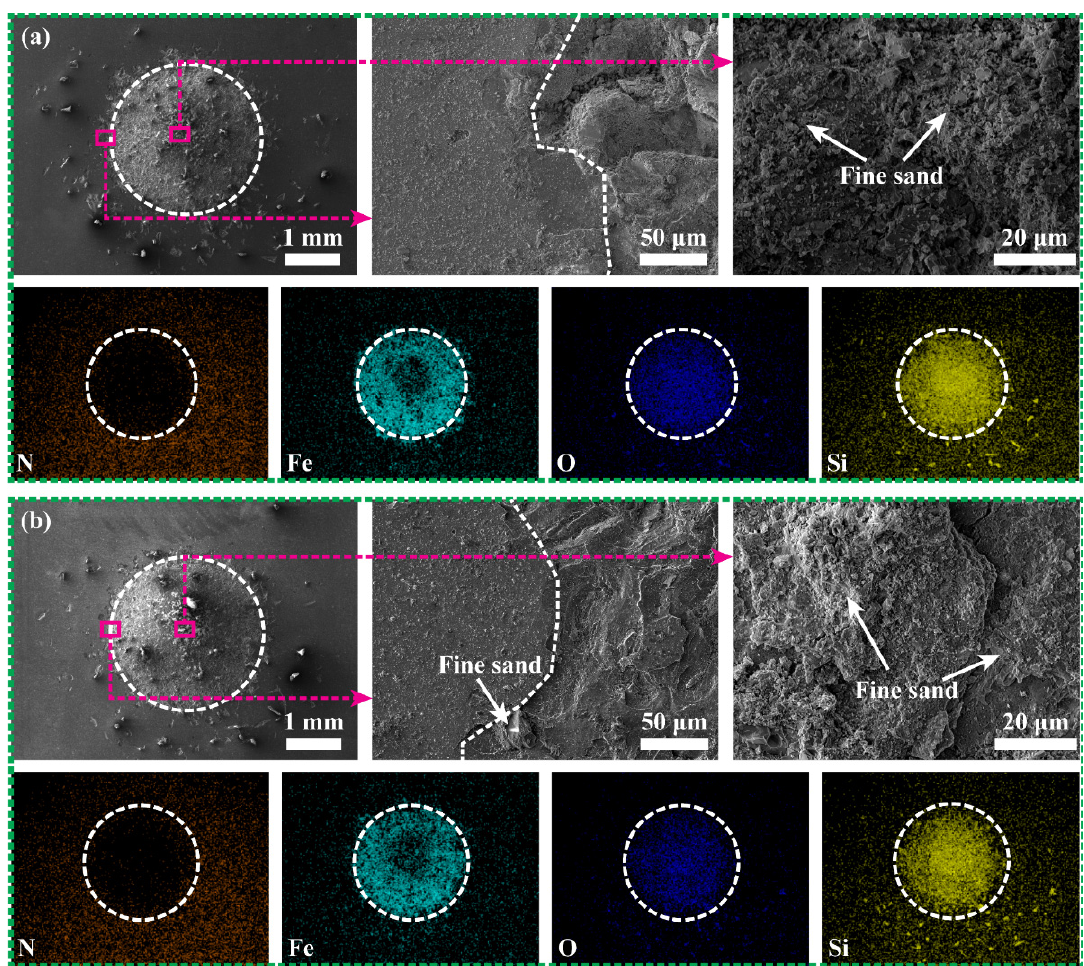
Figure 13. Wear scar morphology and elemental distribution of CrAlN/TiSiN under sand conditions: ( a ) Multilayer and ( b ) Nanomultilayer.